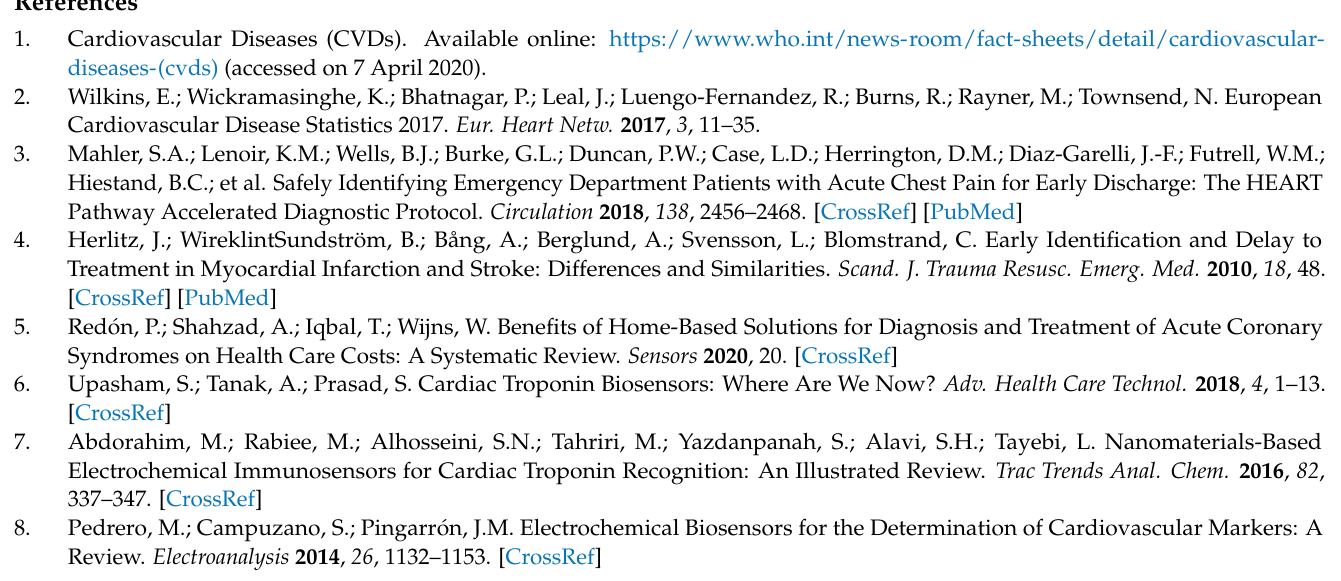
Table S2: Mann-Whitney test for clinically normal and abnormal samples, Table S3: Confusion matrix for the proposed algorithm but with a cut-off value of 0.1 µ